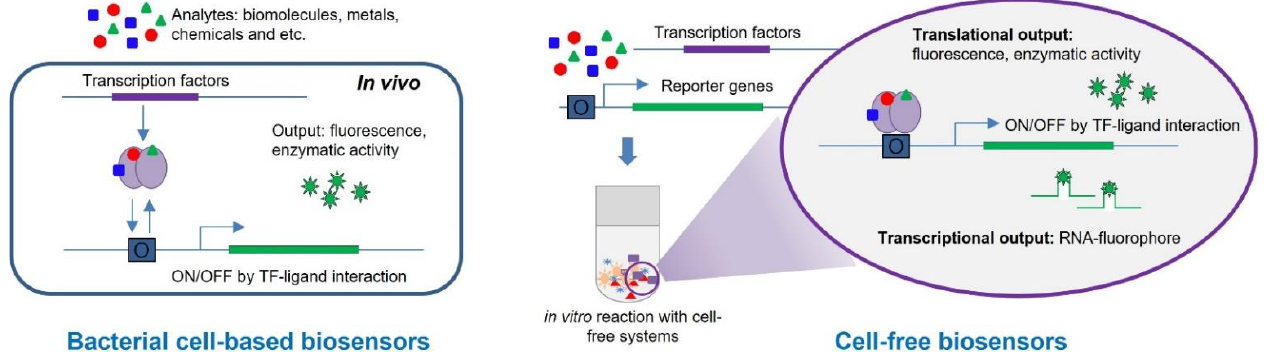
Figure 1. Illustration for the working mechanisms of TF-based biosensors. The cell-based biosensors use the cellular machinery to sense and to report signals as translational outputs ( left ). The biosensors based on cell-free systems use prepared cellular components to sense in vitro and employ both translational and transcriptional outputs as reporting signals ( right ).